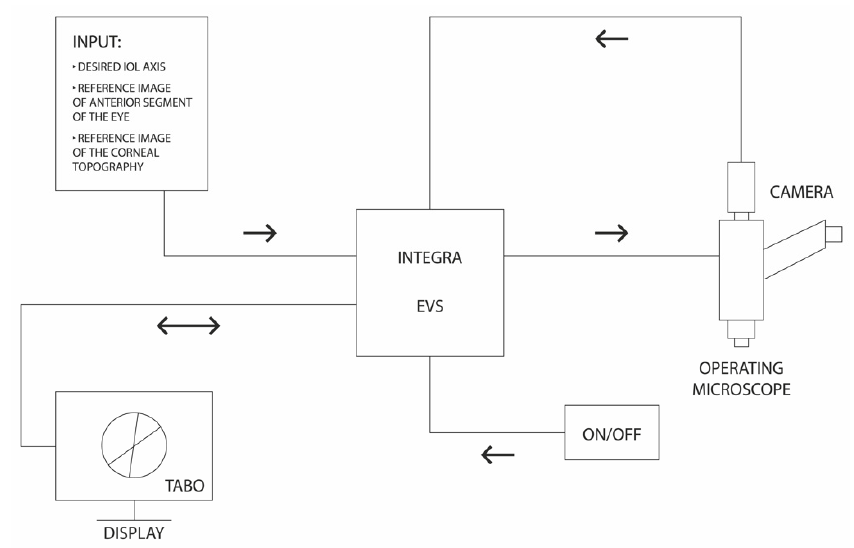
Figure 3. Schematic diagram of the operation of the INTEGRA system. EVS—computer platform on which the INTEGRA software runs.